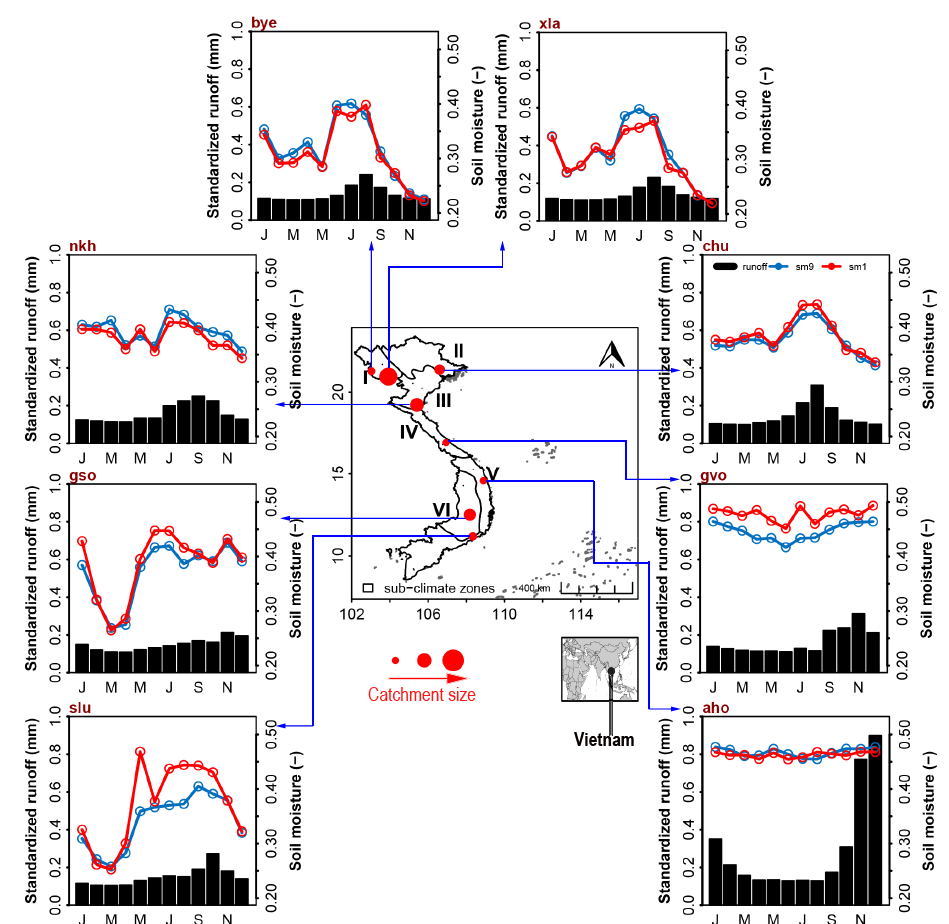
Figure 1. Locations of eight catchments (red circle represents catchment centroid) in Vietnam, and their monthly averaged runoff (black bar), monthly averaged soil moisture estimated from SMAP 9 km (SM9, blue line), and monthly averaged soil moisture estimated from SMAP 1 km (SM1, red line). The runoff values were calculated based on the period of 2013–2019, while soil moisture values (volume soil moisture) were calculated based on the period of 2017–2019. A rescaling has been applied for the runoff time series to compare its variation across catchments. The circle size indicates relative size of the catchment. The Roman numerals indicate contrasting climate regions where the studied catchments located in. These regions are defined following